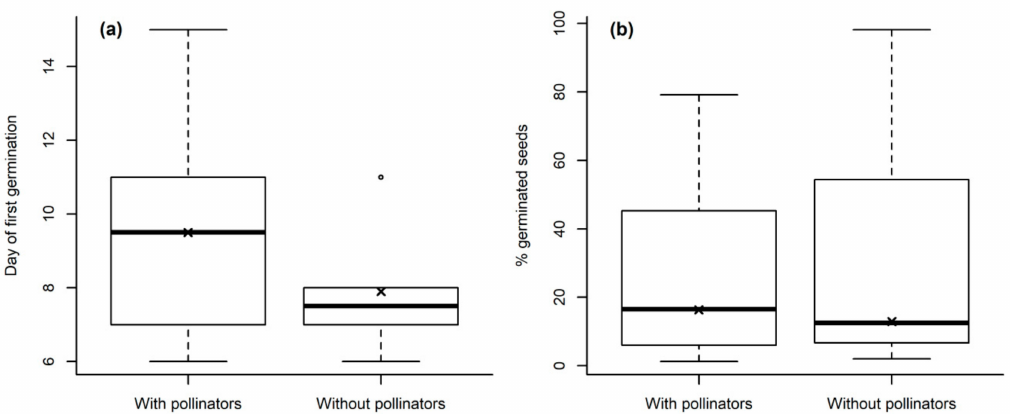
Figure 3. ( a ) Day of first germination; and ( b ) percentage of germinated seeds for seeds collected from the two treatments (for ten species that germinated in both treatments only). The boxplots show the median per group (solid line), crosses the mean, the boxes represent the 25th and 75th quantile, whiskers the normal data range and circles the outliers.